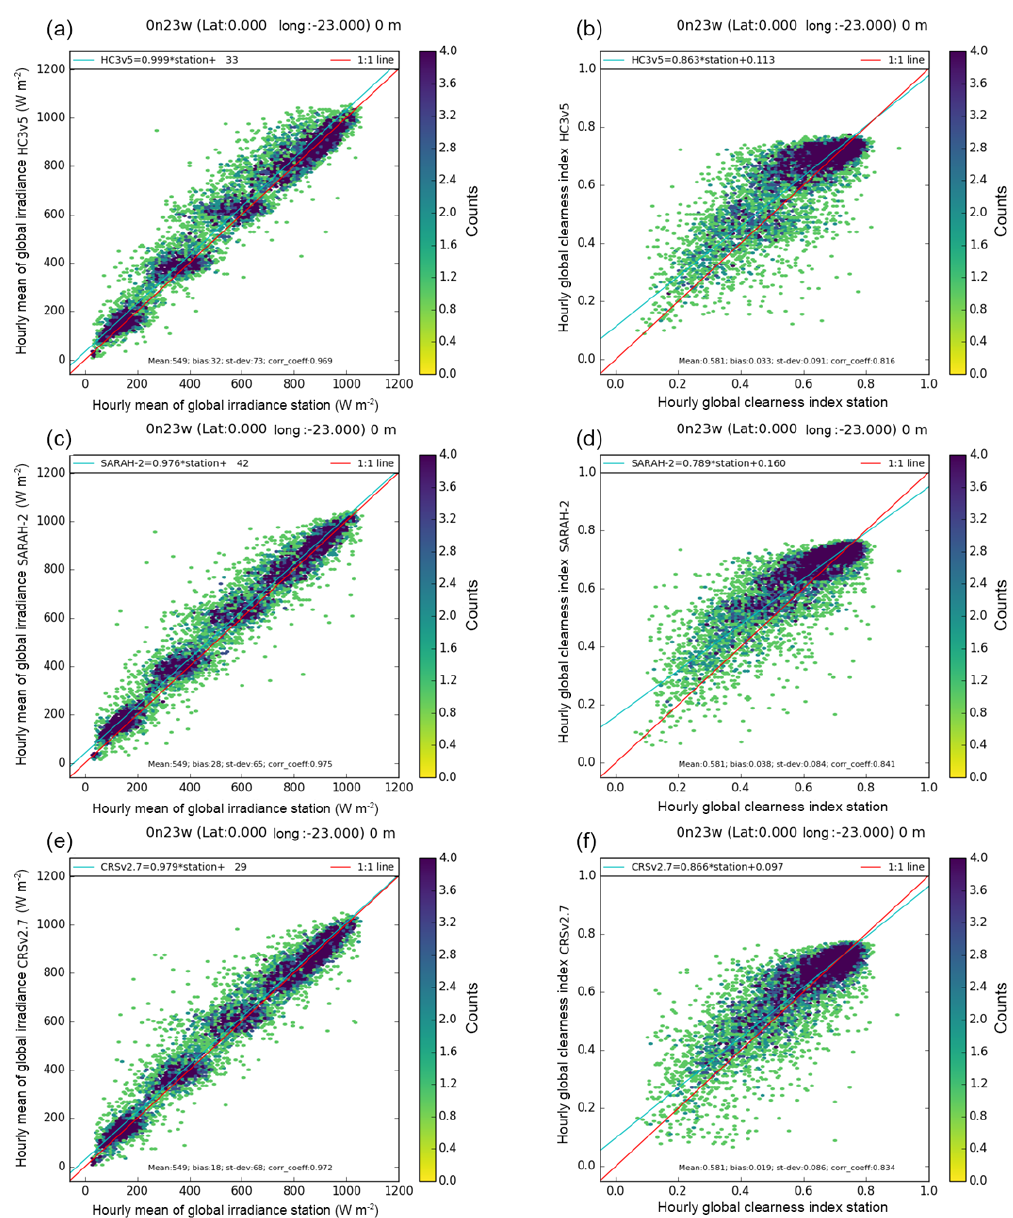
Figure C1. The 2-D histograms of PIRATA measurements (horizontal axis) and data sets (vertical axis) at 0 ◦ N, 23 ◦ W for E and KT. HC3v5: (a) and (b) ; SARAH-2: (c) and (d) ; CRS: (e) and (f) . Ideally, the dots should lie along the red line (1:1 line). The blue line is the affine function fitted over the points and should ideally overlay the red